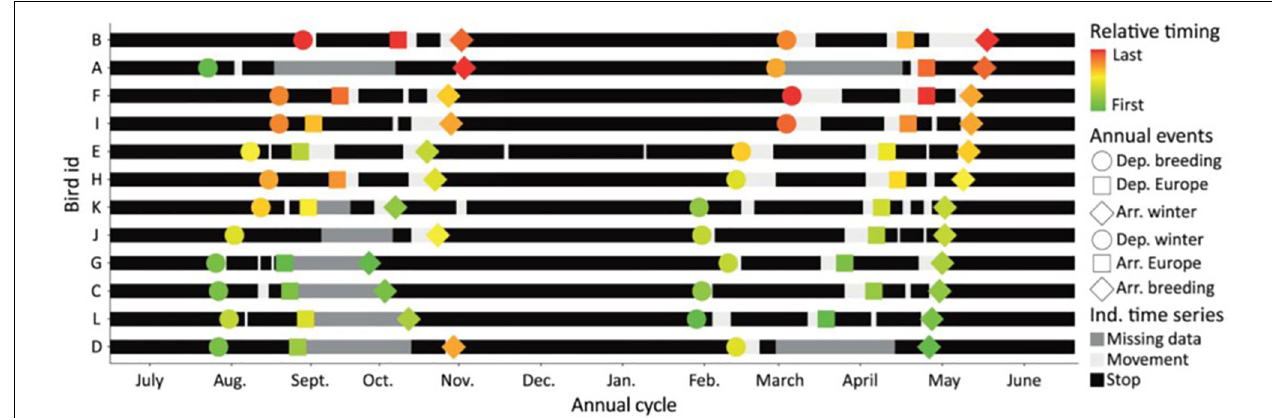
FIGURE 8 | Carry-over effects across the annual cycle for migratory adult European Nightjars. A graphical presentation of distributions of stops and movements in the annual cycle for European Nightjars tracked by microdataloggers, plotted with respect to starting date 1 July. Black bars represent stationary periods and the pale gaps show time of movement. Gray sections refer to periods for which occurrence of stops could not be resolved. The dots show the individual’s timing of the six distinct annual events as shown in inset, and the color gradient shows the order of the birds in each event. Green illustrate the first bird and red the last bird, sorted by the date of arrival to the breeding area. From Norevik et al. (2017).